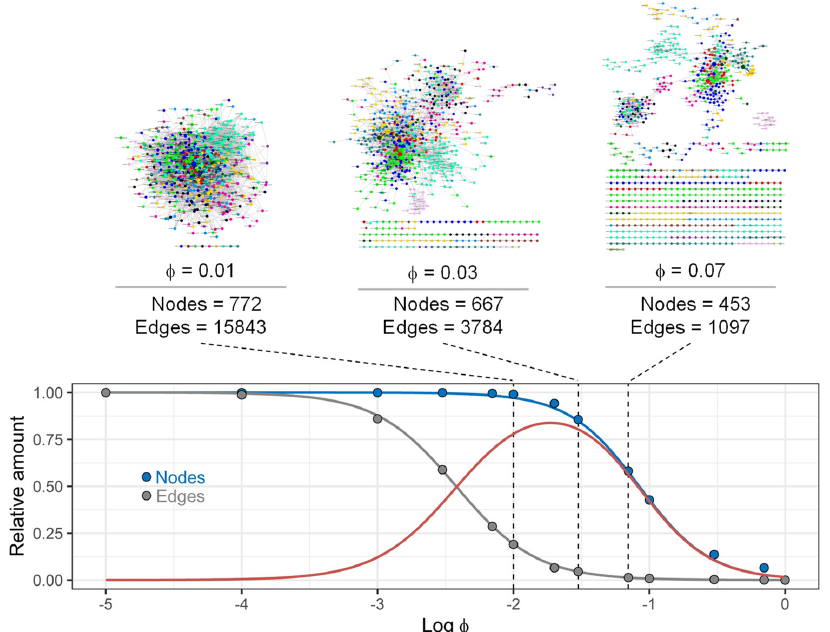
Figure A7. Relationship between 𝜙 -correlation and graph density. Drug prescription networks at the fifth ATC level were created by adopting different 𝜙 -correlation values (from 0.00001 to 1). The number of connected nodes (blue dots) and edges (grey dotes) in these networks was determined and analysed using logistic models (blue and grey lines, respectively). The red curve displays the difference between the blue and the grey curves; the x -coordinate of its maximum is denoted as φ max . Nodes are coloured according to the 14 groups found at the first level of the ATC classification